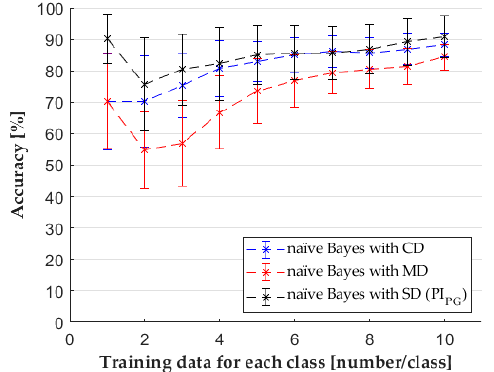
Figure 9. The results of naïve Bayes classifier with the different datasets.